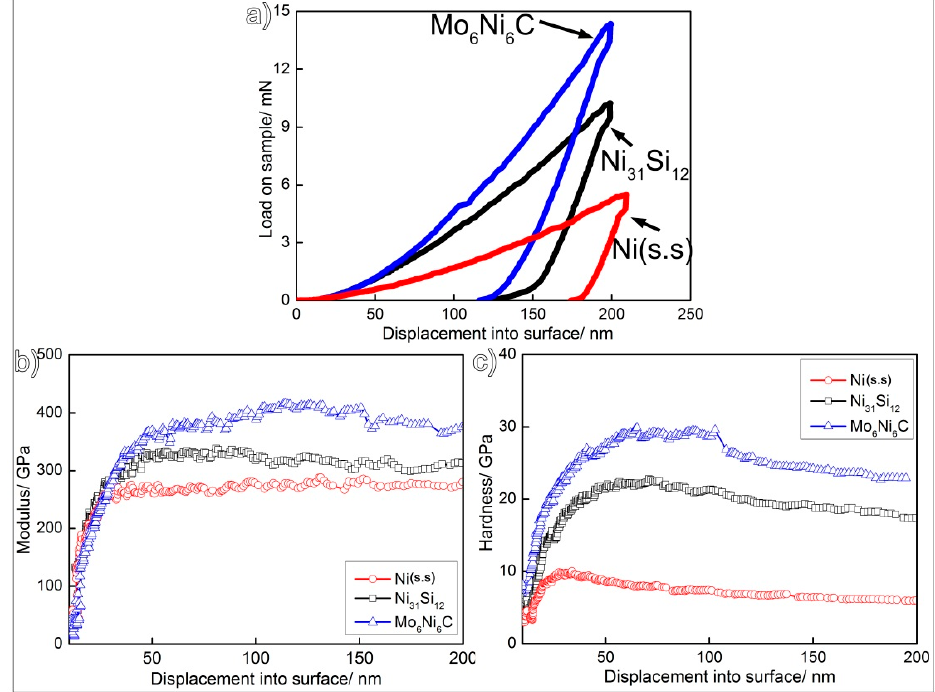
Figure 10. Nanoindentation results of ( a ) load–displacement curve, ( b ) indentation modulus– displacement curve, and ( c ) hardness–displacement curve for the Mo 6 Ni 6 C, γ -Ni 31 Si 12 , and α -Ni (s.s).